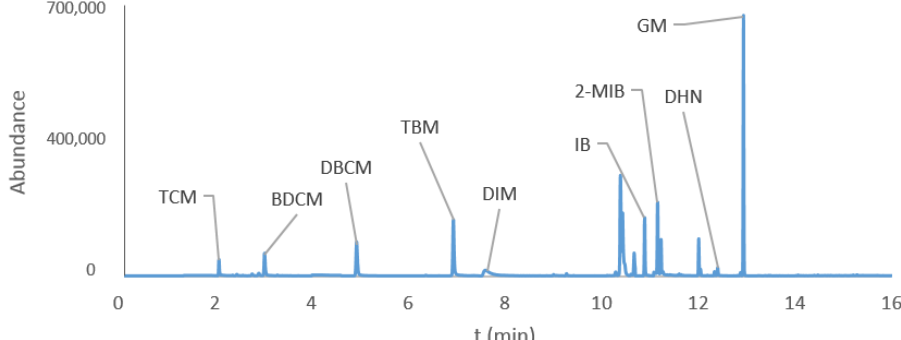
Figure 3. Chromatogram in SCAN mode of a Milli-Q water blank buffered and spiked with 10 µg/L of TCM (rt 2.1 min), BDCM (rt 3.0 min), DBCM (rt 5.0 min), TBM (rt 7.0 min), DIM (rt 7.6 min), IB (rt 10.9 min), 2-MIB (rt 11.1 min), DHN (rt 12.4 min), and GM (rt 12.9 min). Table 2. HS-SPME optimal conditions.